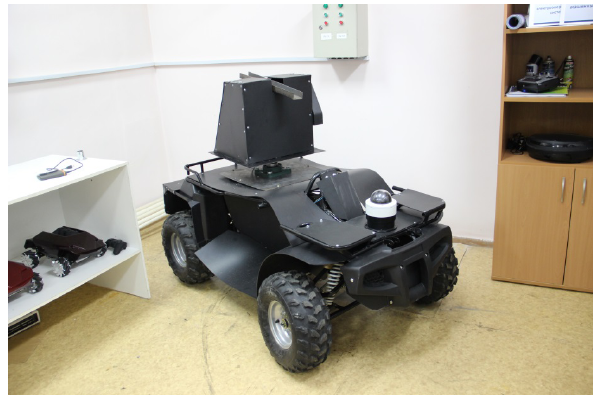
Figure 1: ATV with